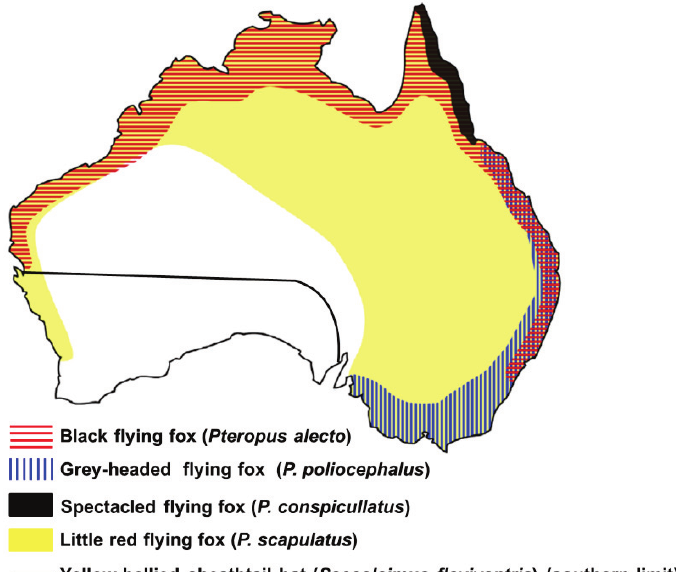
Figure 1. Distribution of ABLV host reservoir species. Adapted from [12 –